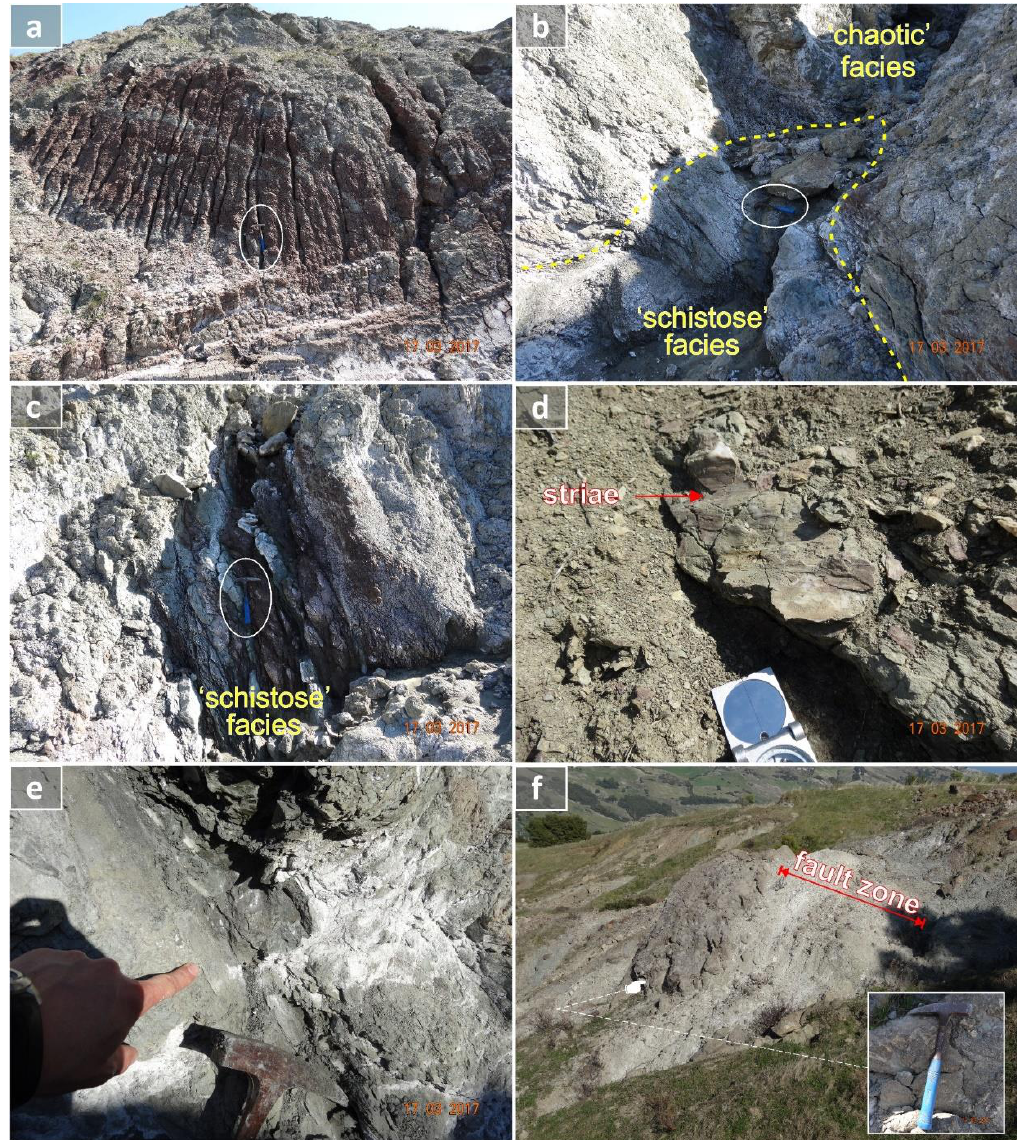
Figure 3. Field photographs of rock types and examples of tectonic structures outcropping in the study catchment. Varicolored clay-shale Formation: ( a ) “chaotic clayey” facies and ( b , c ) “schistose” facies. Tectonic structures: ( d ) WNW-ESE striking fault plane with left lateral transcurrent indicators; ( e ) dip-slip normal kinematic on a N-S fault plane; ( f ) fault damage zone constituted by cataclasite and breccia along an E-W trending fault.